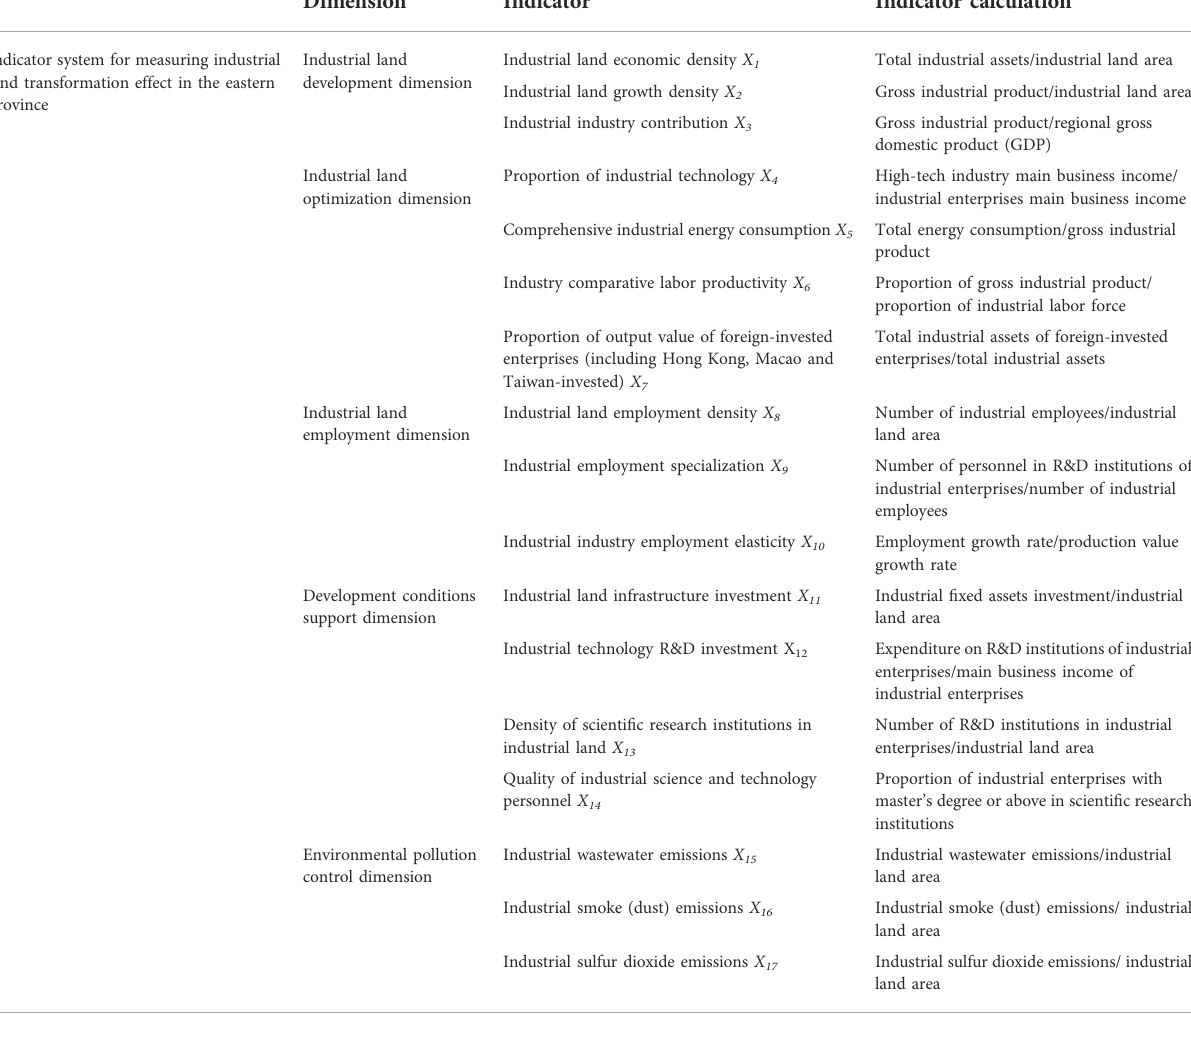
TABLE 1 Indicator system for measuring industrial land transformation effect. Dimension